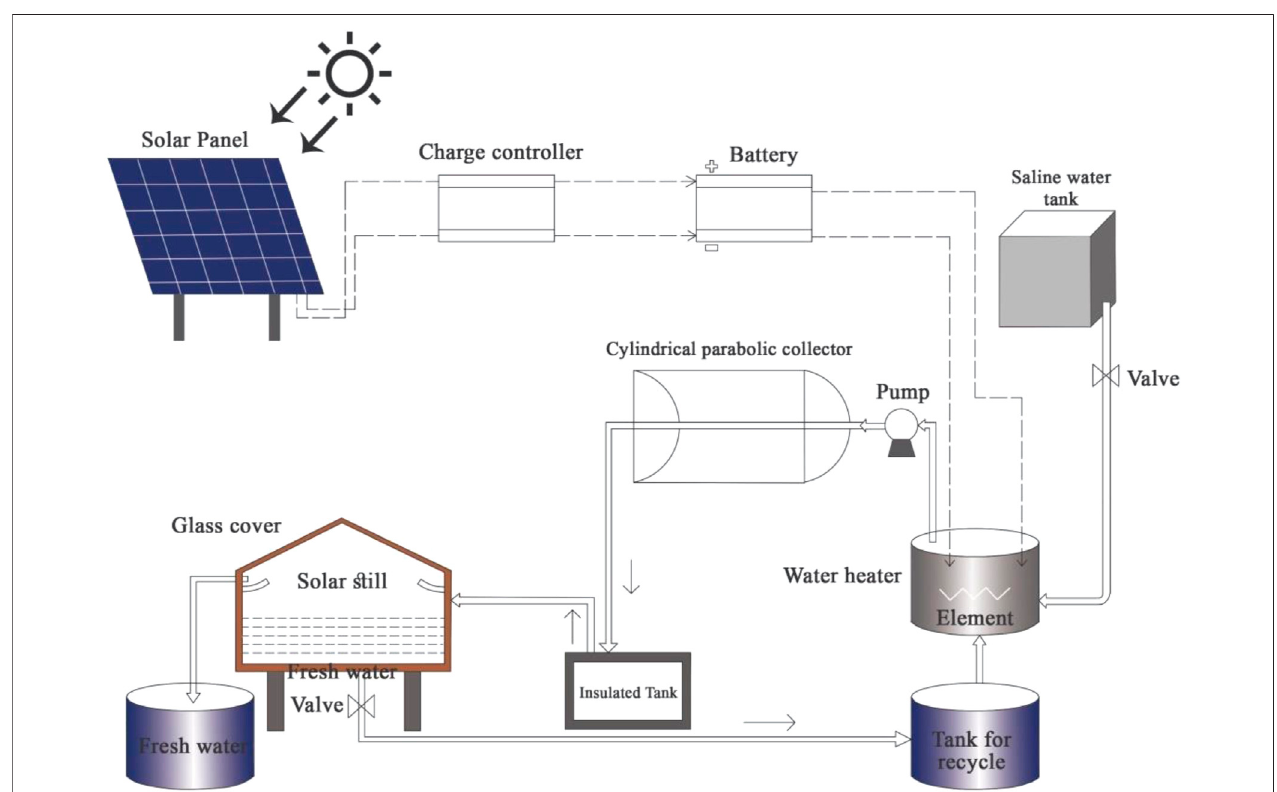
FIGURE 4 | Solar desalination system with a collector, heater, and PV (Bagheri et al., 2021).